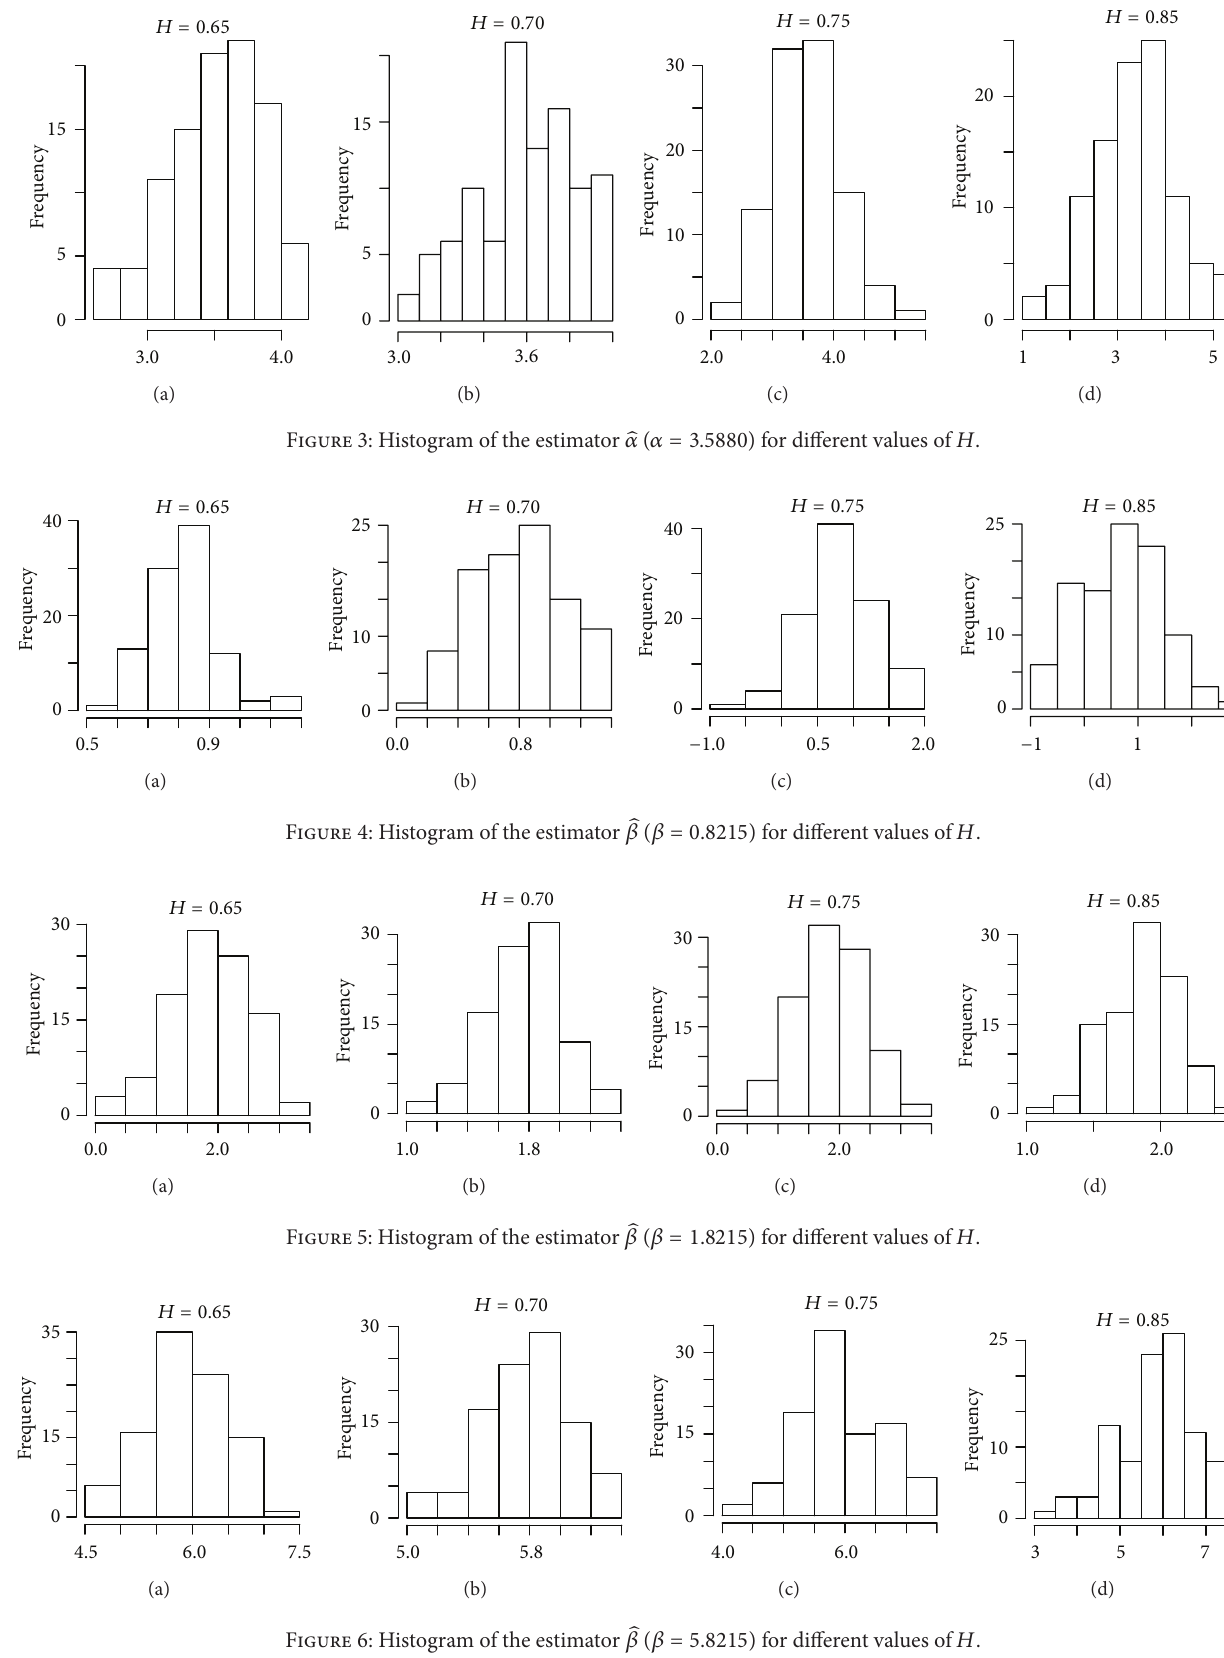
Figure 6: Histogram of the estimator